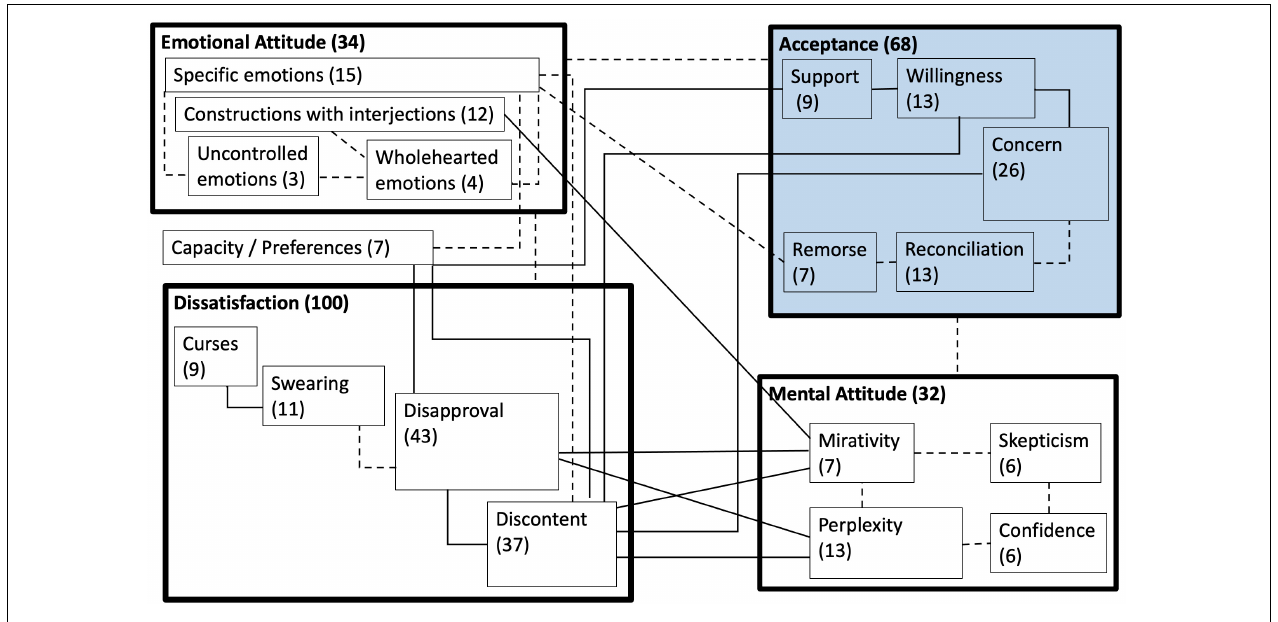
FIGURE 4 | A radial category model of the network of Attitude